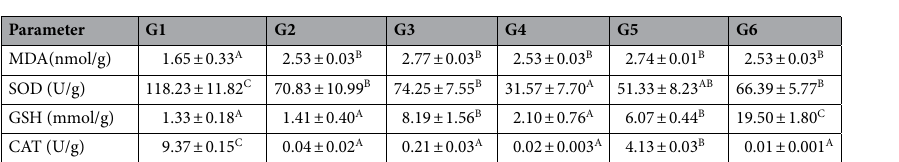
Table 4. The level of malondialehyde (MDA) and reduced glutathione (GSH) as well as the activities of superoxide dismutase (SOD) and catalase (CAT) in the normal negative control group (G1), tumor control group (G2), doxorubicin-treated group (G3) and groups treated with 100, 200 or 400 mg/kg of PSO nano- emulsion (G4, G5, G6) respectively. Data is displayed as mean ± standard error. Means marked with the same superscript letters are insignificantly ( p > 0.05) different, whereas those marked with different ones are significantly ( p < 0.05) different.